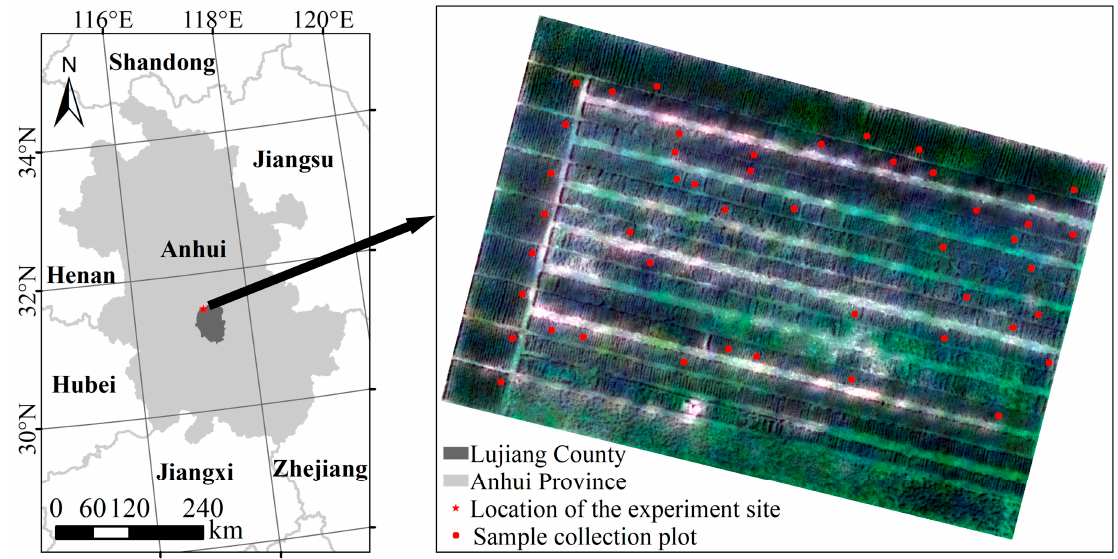
Figure 1. Experimental area location and field survey sampling positions.